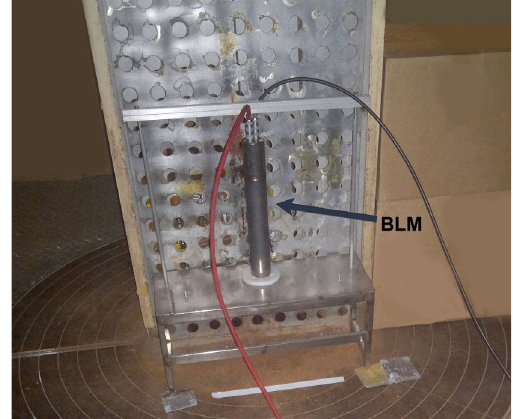
distances.FIG. 11. The γ ray irradiation experiment for the BLM using a 60 Co source. The source is hidden in a well when not used and lifted up during the